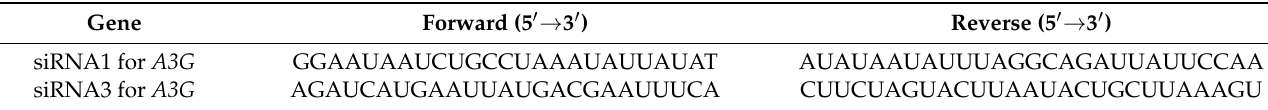
Table A1. Sequence of siRNAs.